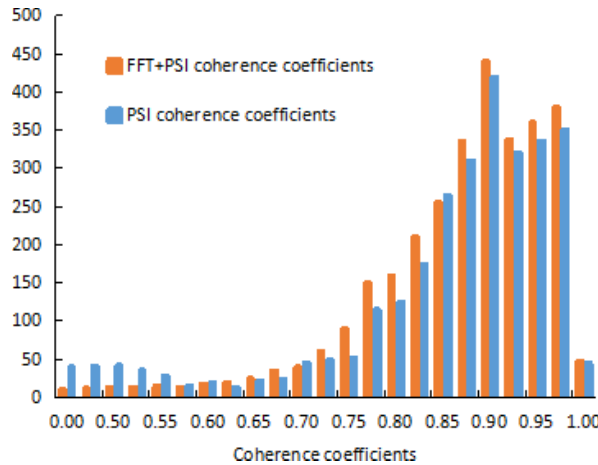
Figure 3. Comparison of PSs coherence coefficients.